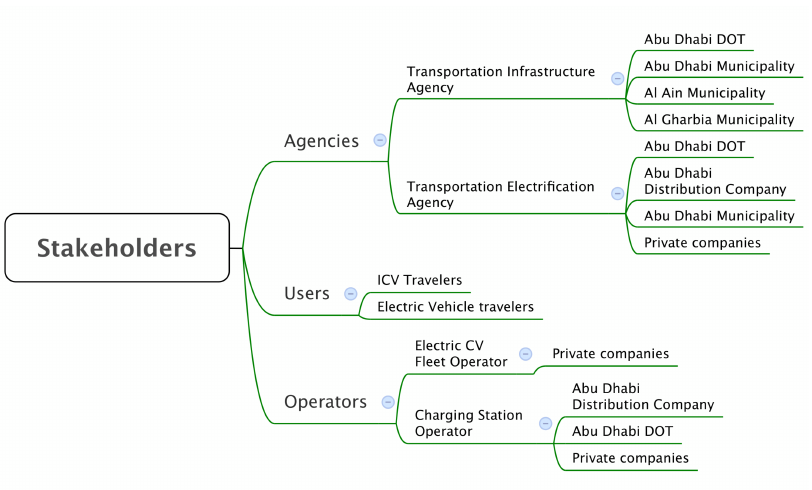
Figure 14. Integration of EVs as new stakeholders in Abu Dhabi’s ITES